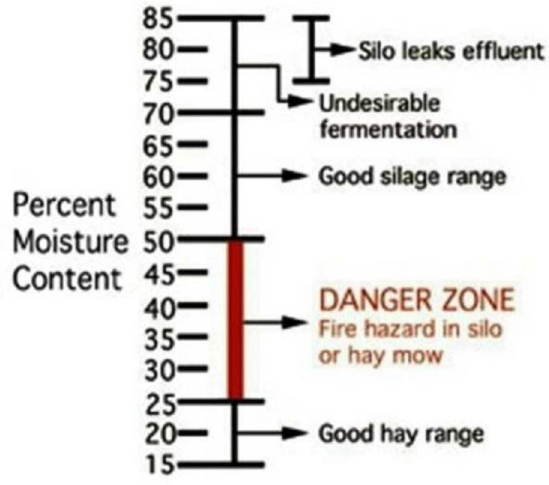
Figure 2. Relationship between the moisture content in silos and fire hazards [23].